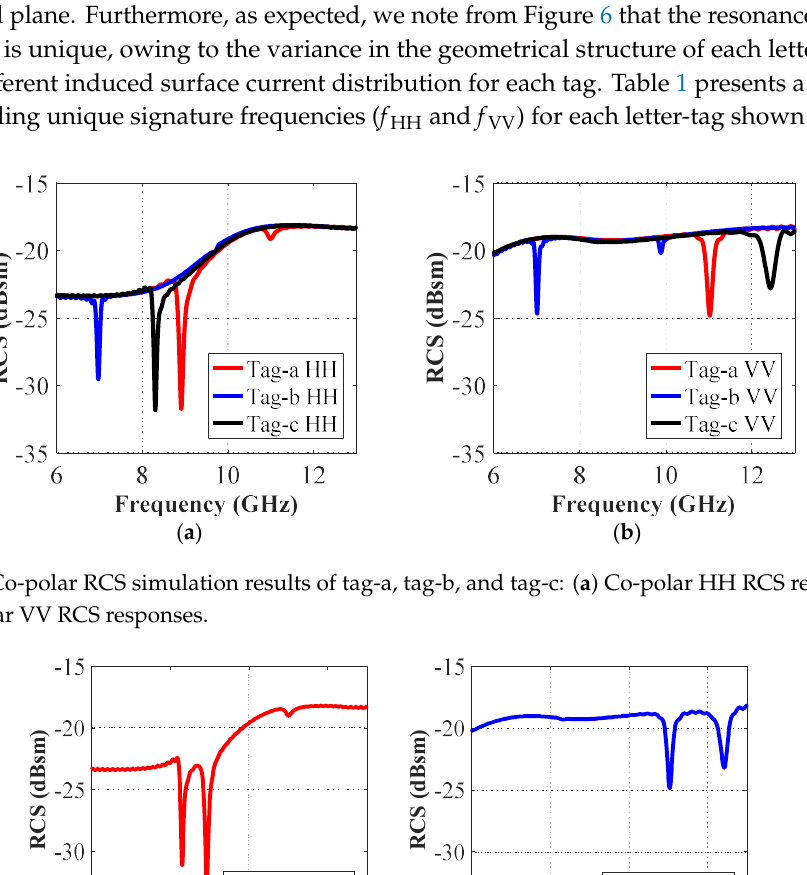
Figure 6. Co-polar RCS simulation results of tag-a, tag-b, and tag-c: ( a ) Co-polar HH RCS responses; ( b ) Co-polar VV RCS responses. Table 1. Unique frequency signature of single tag letters from Figure ure.